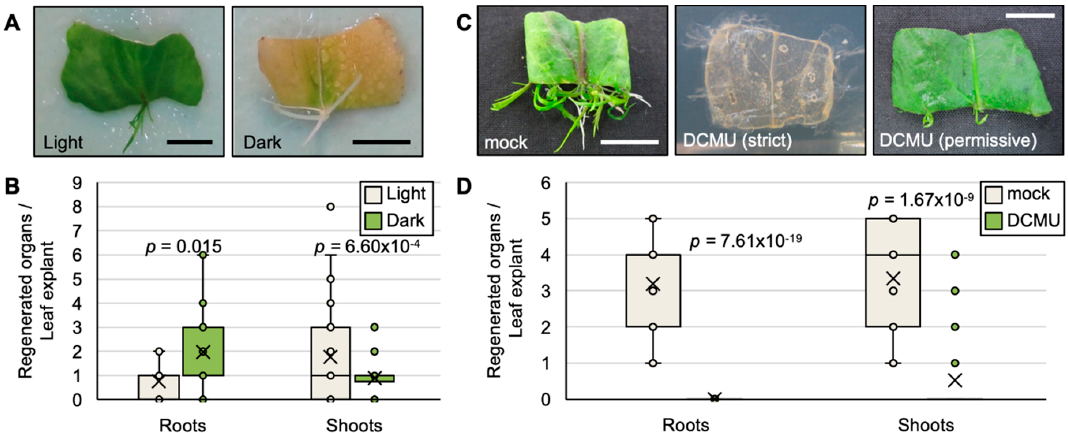
Figure 2. Effects of photosynthetic inhibition on vegetative propagation in R. aquatica . ( A , B ) Plantlet regeneration under dark conditions. ( A ) Effects on leaf fragments at day 22. ( B ) Quantification of regenerated roots and shoots at day 22 ( n = 30). Vertical line and horizonal line indicate the number of regenerated organs per leaf explant, and roots or shoots, respectively. ( C , D ) Effect of the photosynthesis inhibitor 3-(3,4-dichlorophenyl)-1,1-dimethylurea (DCMU). Mock is dimethyl sulfoxide (DMSO). ( C ) Effects on leaf fragments at day 22. Both strict and permissive effects were observed. ( D ) Quantification of regenerated roots and shoots at day 22 ( n = 32). Vertical line and horizonal line indicate the number of regenerated organs per leaf explant, and roots or shoots, respectively. Scale bars = 1 cm. The average value is indicated by a cross mark in each box plot. Significant di ff erences were determined by Student’s t -test and p values indicate exact